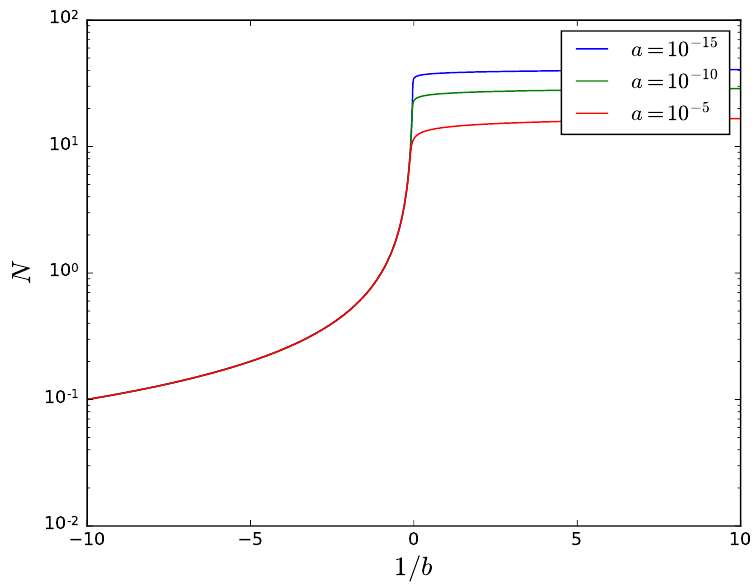
Figure 5 . The exponent N given in eq. (3.19) as a function of 1 =b